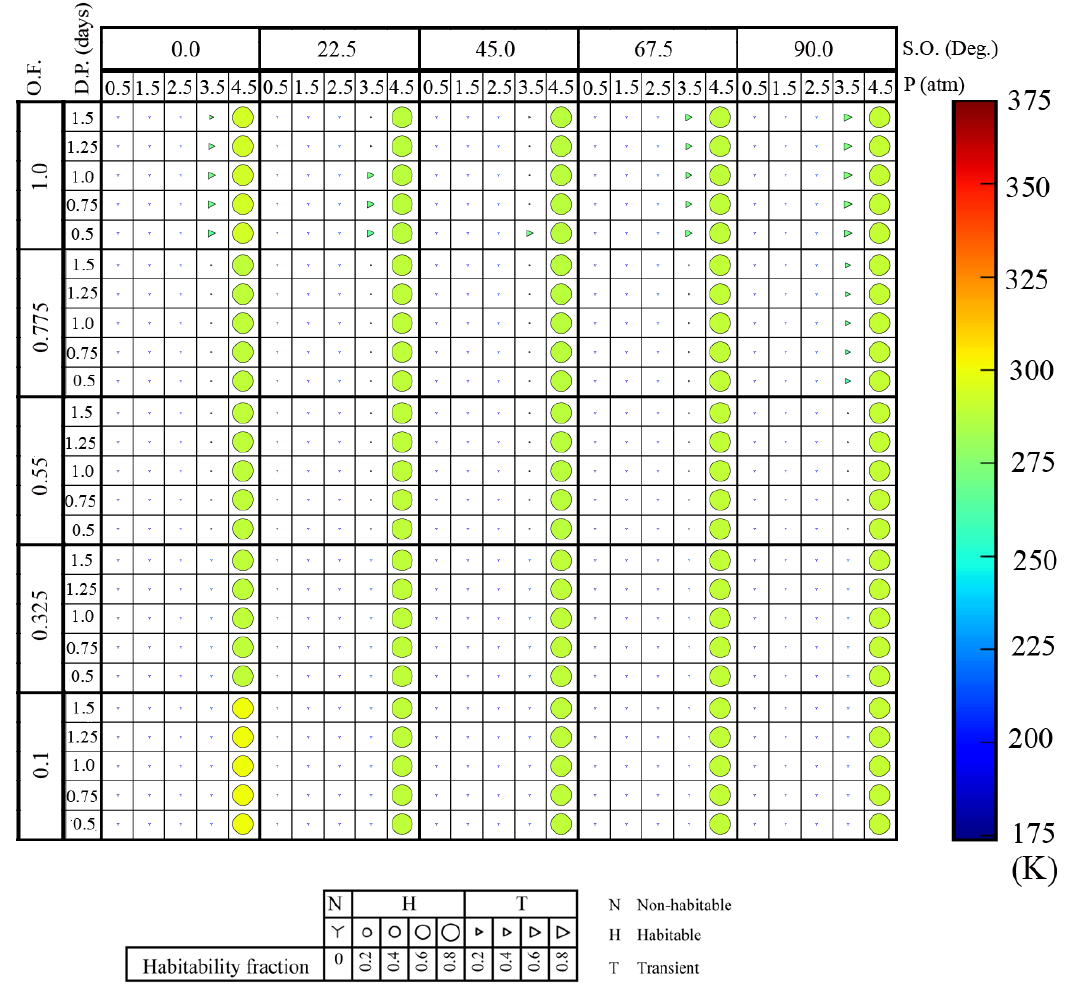
Figure 7. Kepler-62f parameters map - Kepler-62f parameters map - All parameters are in an increasing order from left to right and bottom to up. Pressures are (0.1, 0.4, 0.7, 1, 1.3) atm, Diurnal Periods are (0.5, 0.75, 1.0, 1.25, 1.5) days, Spin Obliquities are (0.0, 22.5, 45.0, 67.5, 90.0) degrees, and Ocean Fractions are (0.1, 0.325, 0.55, 0.775, 1.0). They are displayed in the map,